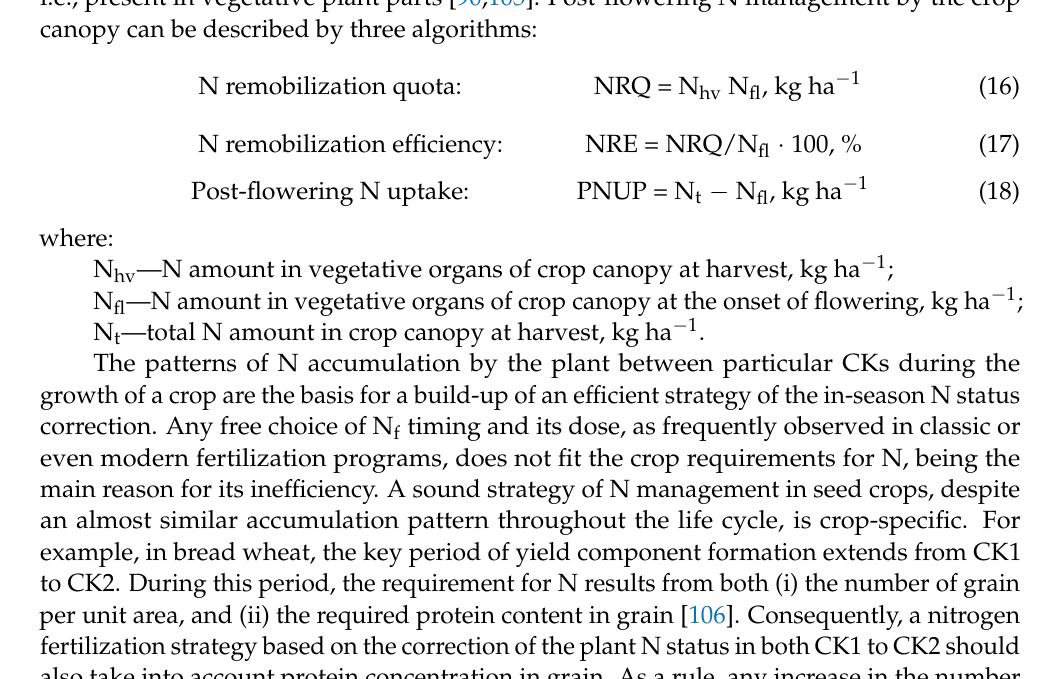
Figure 6. The response of seed density of winter oilseed rape to the content of nitrate nitrogen at the rosette stage and its uptake by the crop up to flowering. (based on [80]. Legend: NN- the content of nitrate nitrogen at BBCH 30; Δ NN—the change of the NN content during the period extending from the rosette up the flowering stage of WOSR growth.